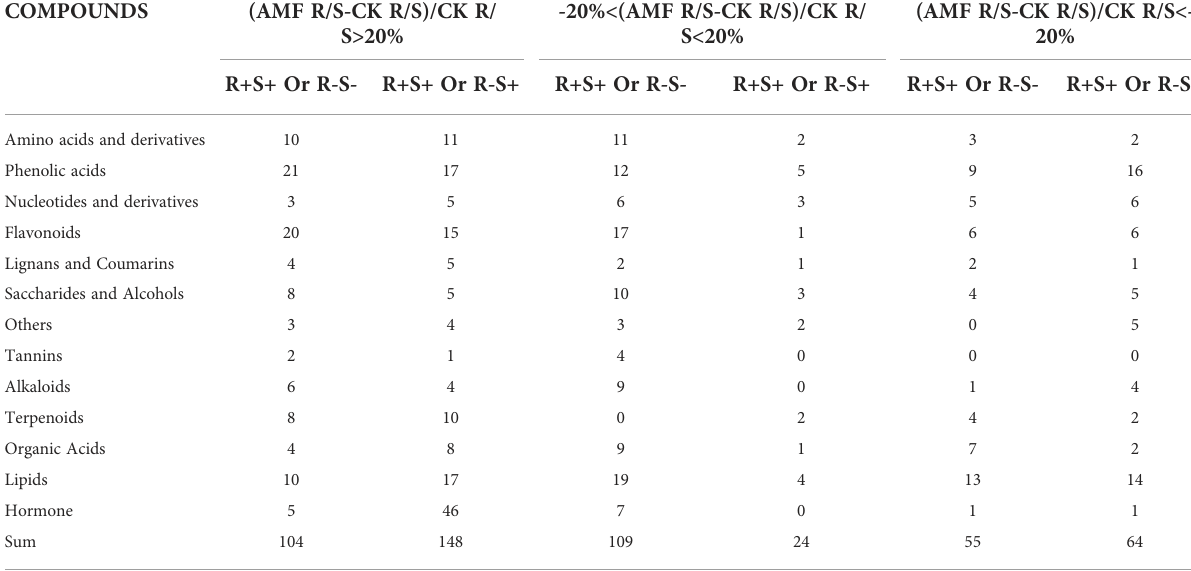
TABLE 1 Variation of the root to shoot ratios of various metabolites in apple plants inoculated with R . irregularis for 60 days.